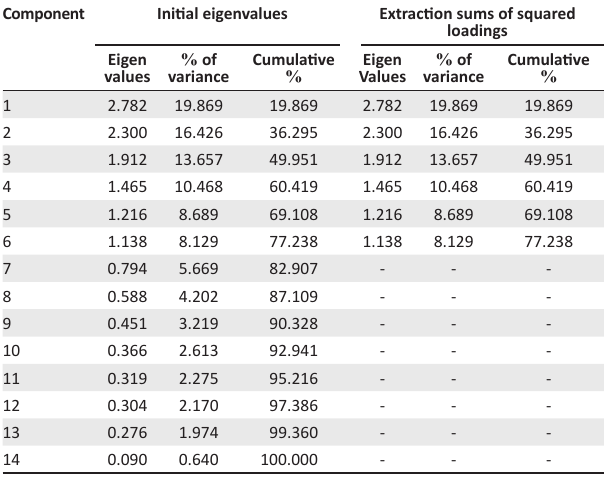
TABLE 3: Total variance